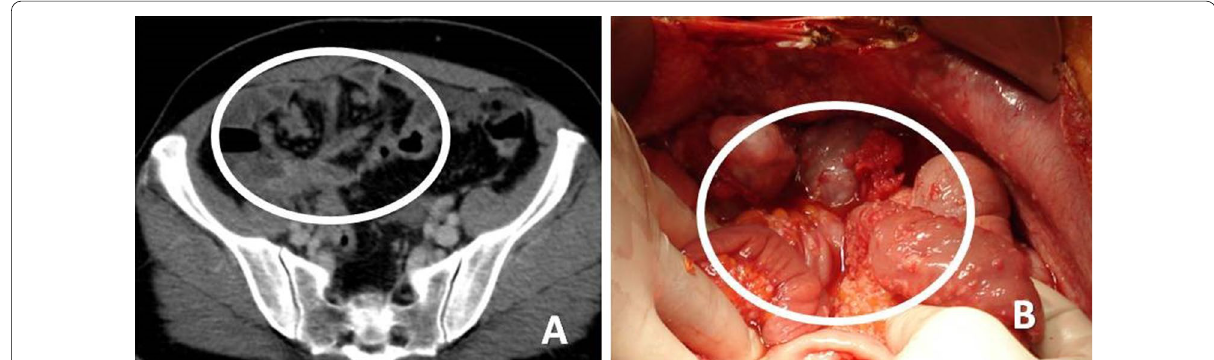
Fig. 9 a Contrast enhanced CT enteroclysis image shows non dilated intestinal loops due to rigidity caused by multiple tiny implants on the surface of the intestinal loops (white circle). b At surgery shorted and distorted intestinal loops with numerous deposits are seen (white circle)